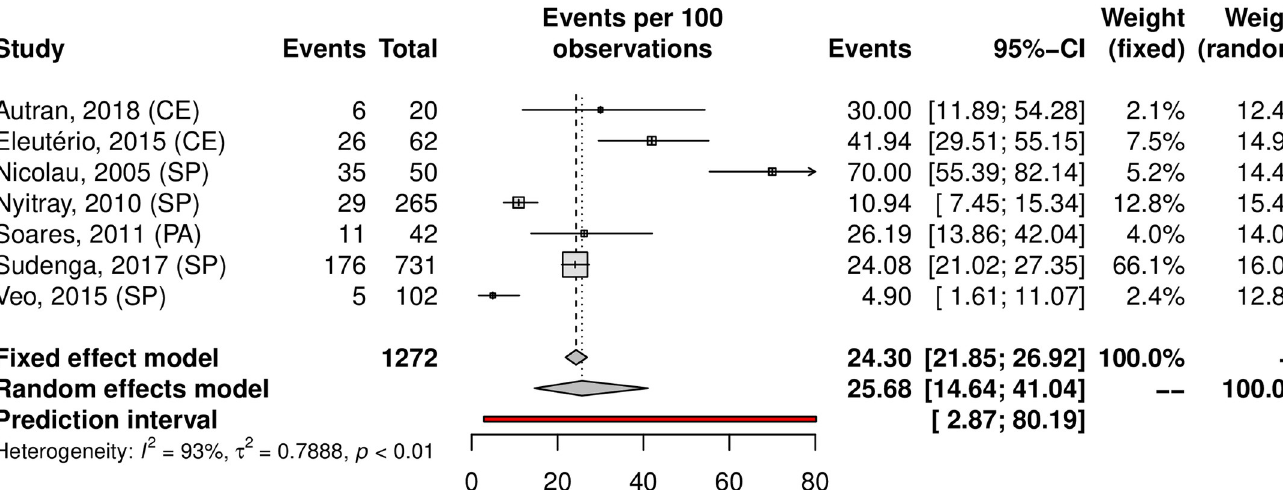
Fig 16. Overall prevalence of anal HPV infection. Forest plot of a metanalysis of studies reporting prevalence of anal infection by HPV in Brazil.